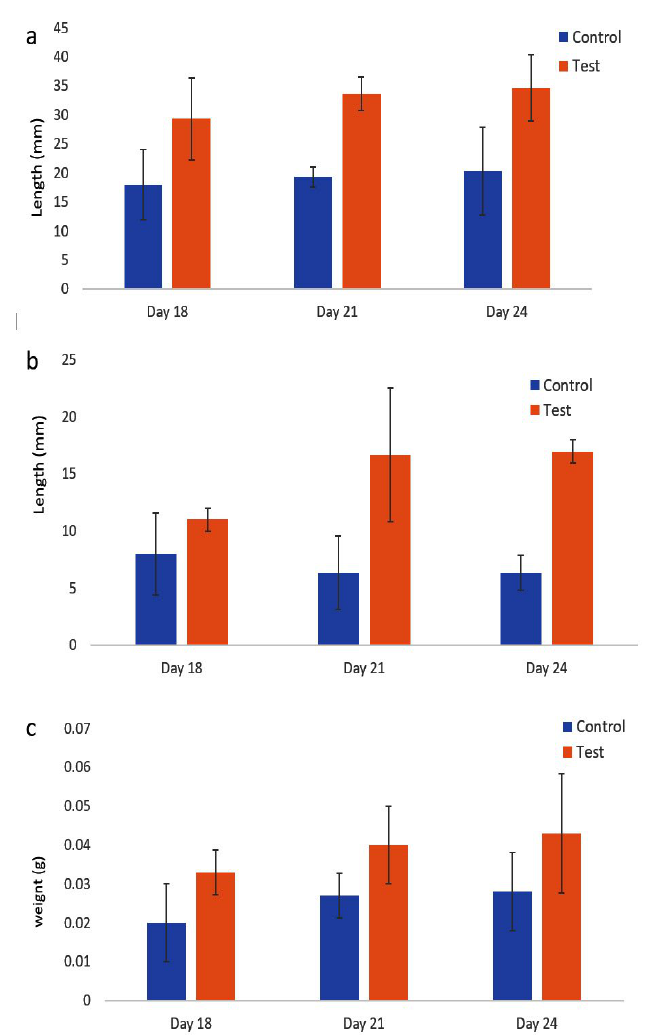
Fig. 7. Parameters measured on day 18, 21 and 24; a-shoot length, b- root length; c- wet